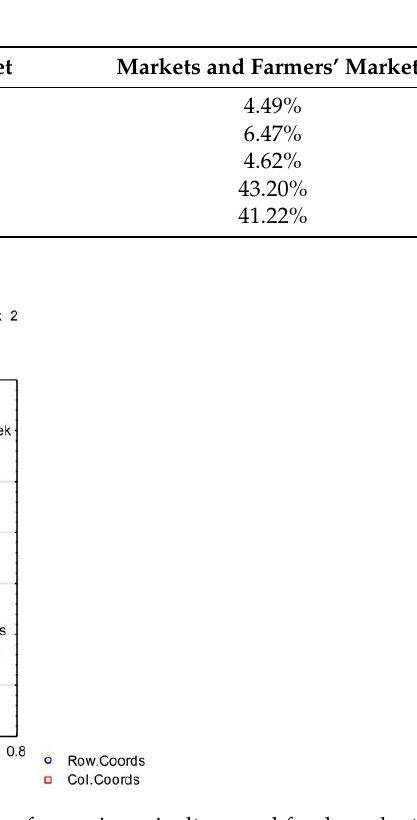
Figure 1. Correspondence maps, place of purchase of organic agriculture and food products and purchase frequency. Source: